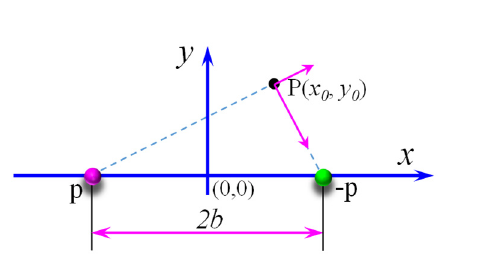
Figure 5. The point magnetic dipole theory.